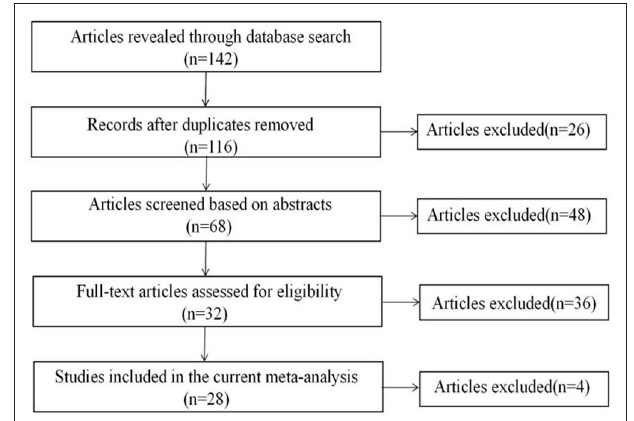
FIGURE 1 | Flowchart of the search and screening